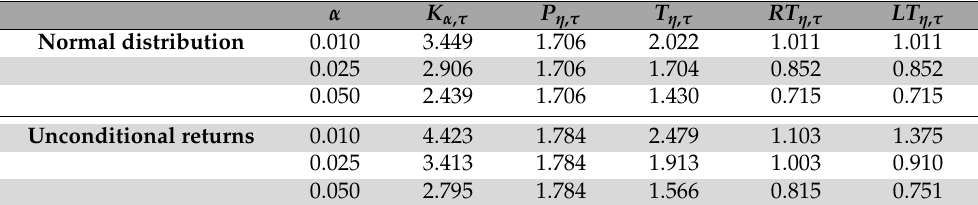
Table A3. Comparison of quantile–based kurtosis, peakedness and tailness—real